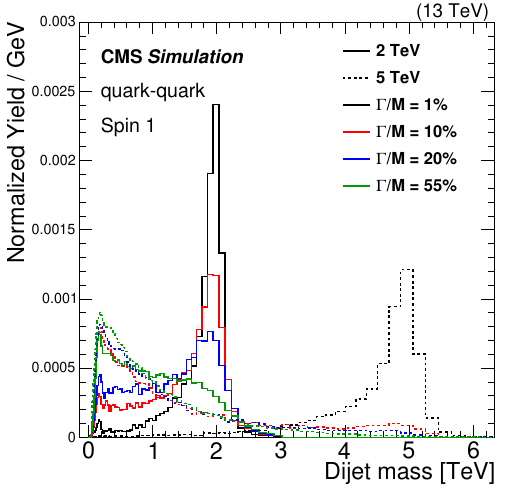
Figure 9 . The reconstructed dijet mass spectra for a vector particle decaying to pairs of quarks are shown for a resonance mass of 2 TeV (solid histogram) and 5 TeV (dashed histogram) for various values of intrinsic width, estimated from the MadGraph 5 and pythia event generators followed by the simulation of the CMS detector